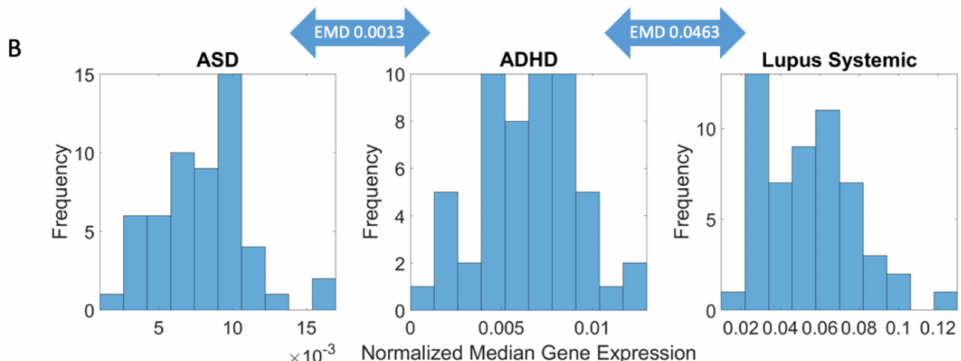
Figure 3. Pipeline of analysis to obtain pairwise similarity measurements between disorders. ( A ) The matrix of N genes × 54 tissues whereby is ij entry is the gene expression from the row i in the tissue j , is transformed into a 1 × 54 vector of median gene expression values (across the matrix rows) represented here in stem form, from the normalized values accounting for the number of genes in each disorder. Each red dot represents the median gene expression at the j th tissue. Three representative disorders are shown. ( B ) Histogram of the genes’ normalized expression correspond to the stem plots of panel ( A ). I take the earth mover’s distance (EMD) pairwise between two disorders (represented in the arrow) and build a matrix of EMD values representing the distance (similarity) between two disorders in the precise sense of genetic information contributing to genes’ expression on tissues.